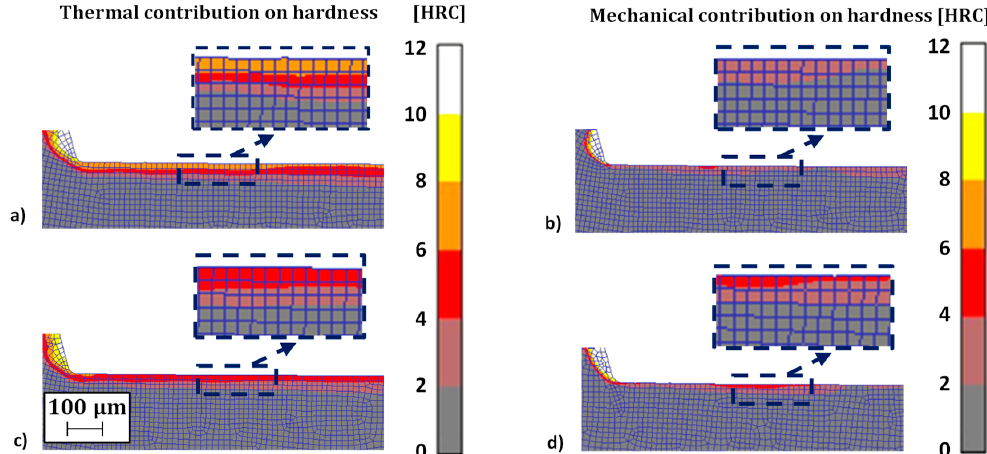
Figure 9. Thermal (phase transformation) and mechanical (dynamic recrystallization (DRX) event)